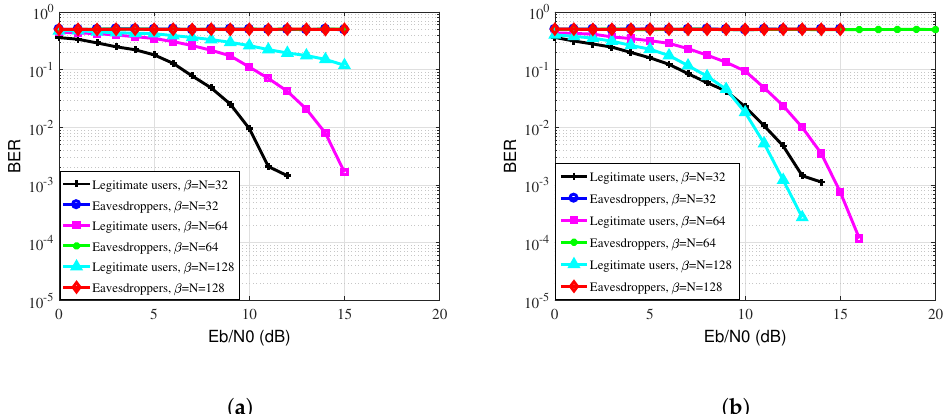
Figure 6. BER of legitimate users and eavesdroppers over the Rayleigh channel. ( a ) BER over Rayleigh channel with BPSK; ( b ) BER over Rayleigh channel with